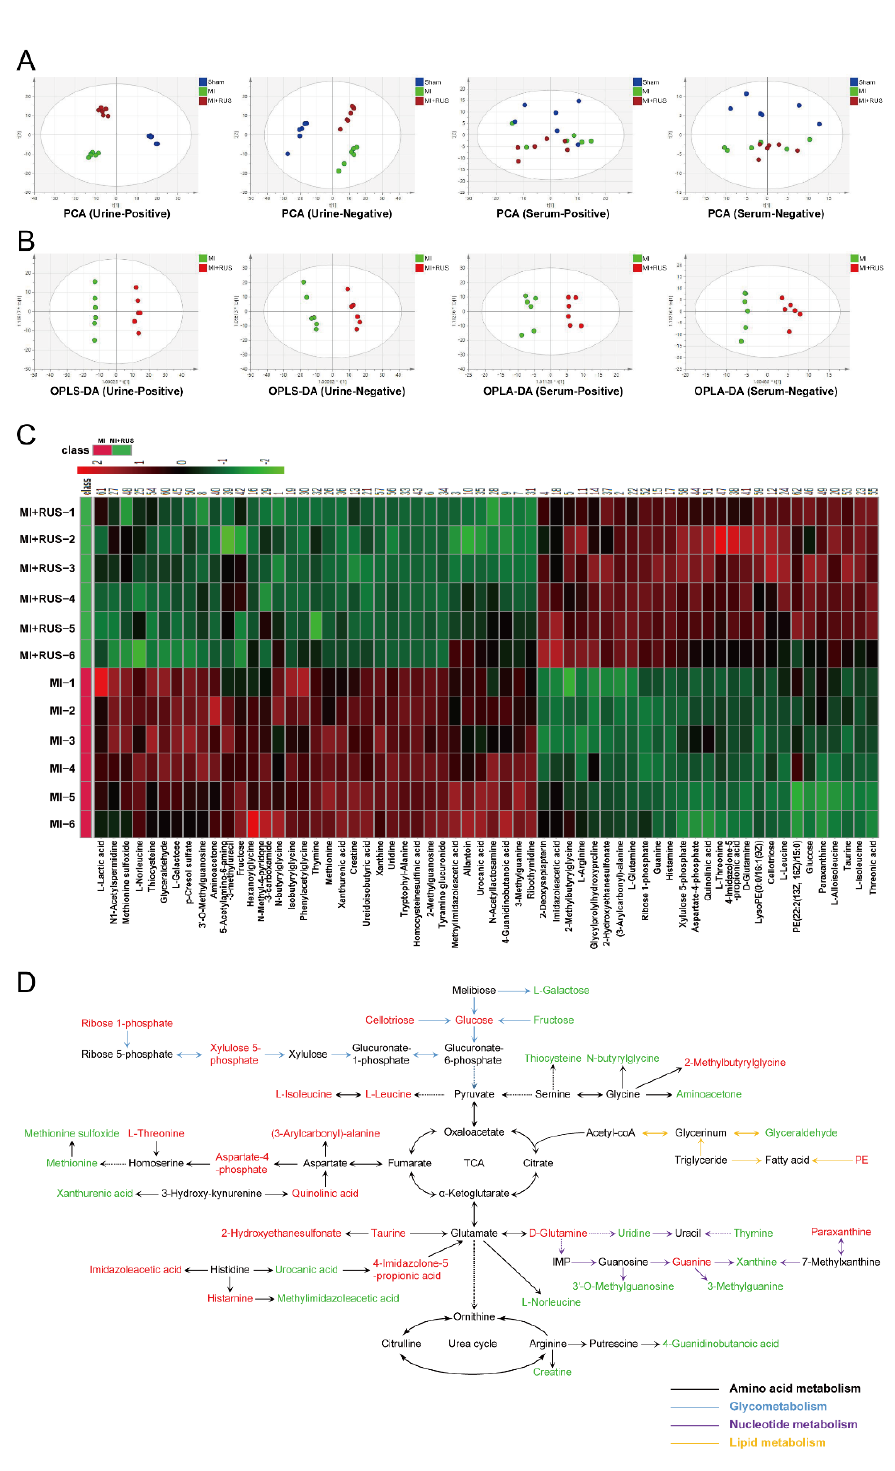
Figure 3. Multivariate analysis and metabolic network of the significantly changed endogenous metabolites. ( A ) PCA score plots of the sham, MI, and MI treated with 0.75 mg/kg RUS groups. ( B ) OPLS-DA score plots of the MI and MI treated with 0.75 mg/kg RUS groups. ( C ) Heat map of 62 differential endogenous metabolites in urine and serum ( n = 6). ( D ) The metabolic network map of the differential metabolites and their changed metabolic pathways. Red metabolites in the network are increased in the RUS group compared with the MI group and the down-regulated metabolites are represented by green.